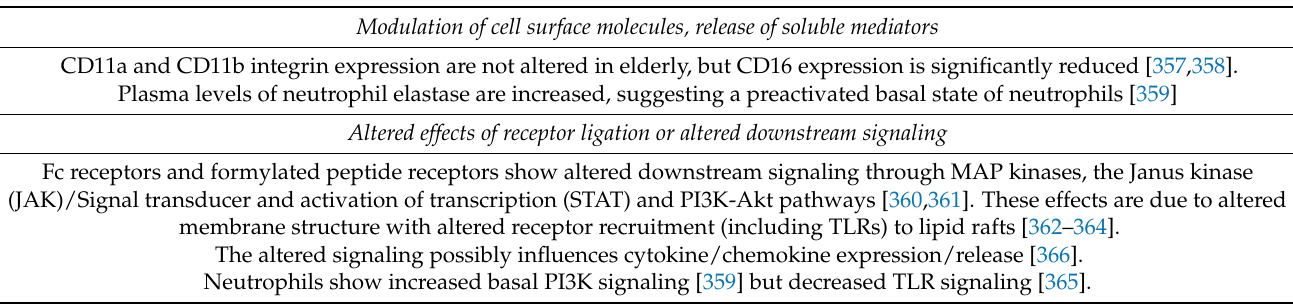
Table 4. Important aging-associated direct and indirect effects on neutrophil